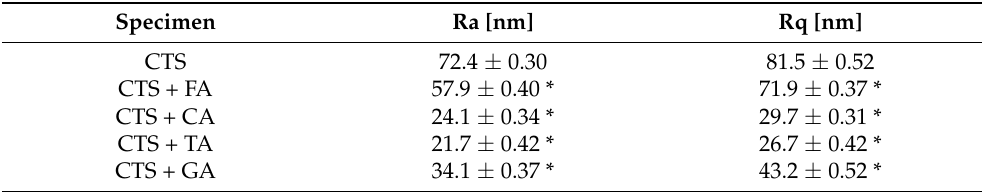
Table 1. Roughness parameters (Ra and Rq) of films ( n = 5; * significantly different from CTS — p < 0.05).